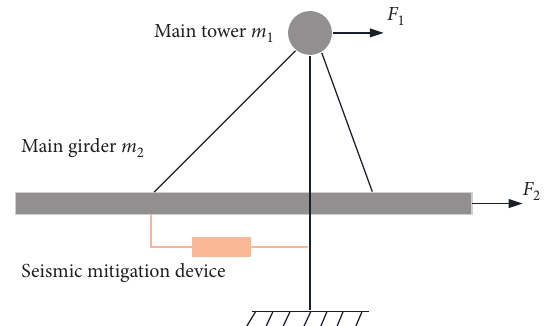
Figure 14: Force transmission from the girder to the